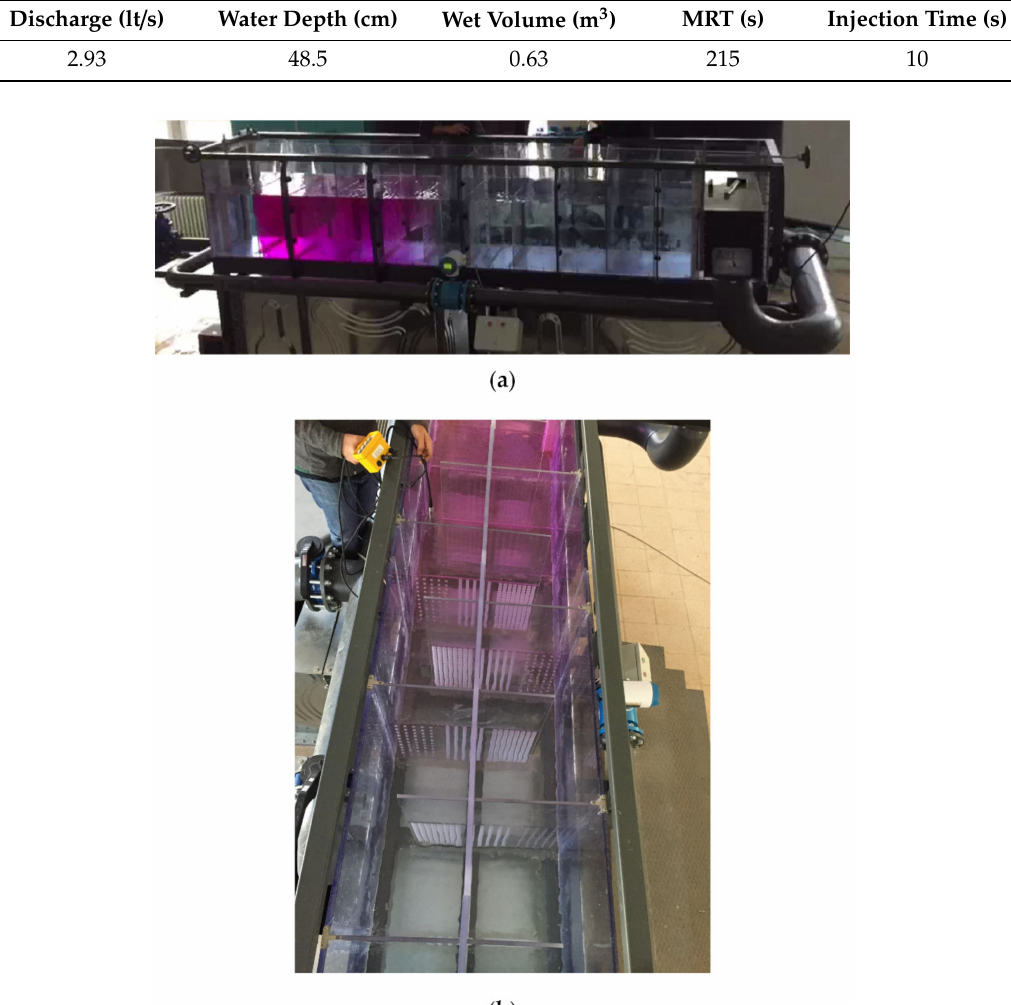
Table 1. Flow conditions used in the experimental studies.